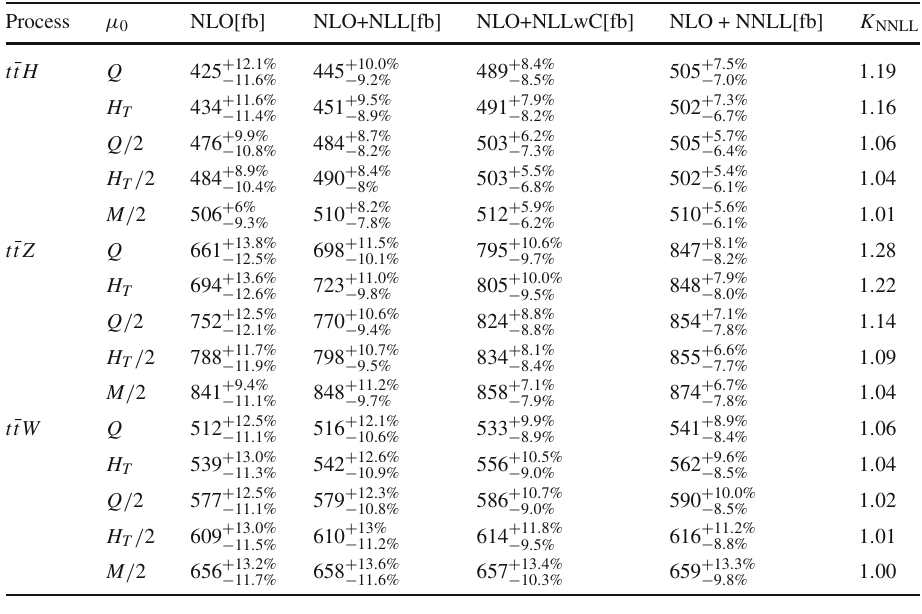
Fig. 1 Graphical illustration of the predictions in Table 1. “NLO” stands here